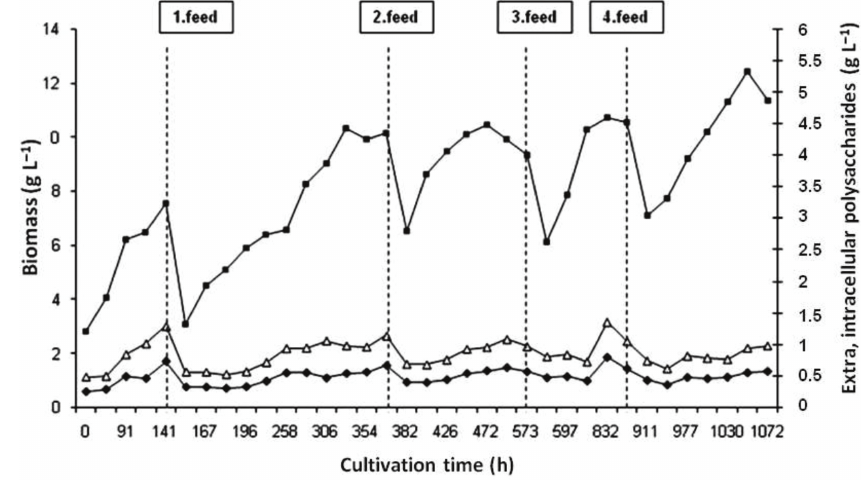
Fig. 8 – Production of biomass and fungal polysaccharides in fed-batch cultivation, feed - ing at 141, 367, 573, and 902 h; ■ biomass; Δ intracellular; ♦ extracellular poly